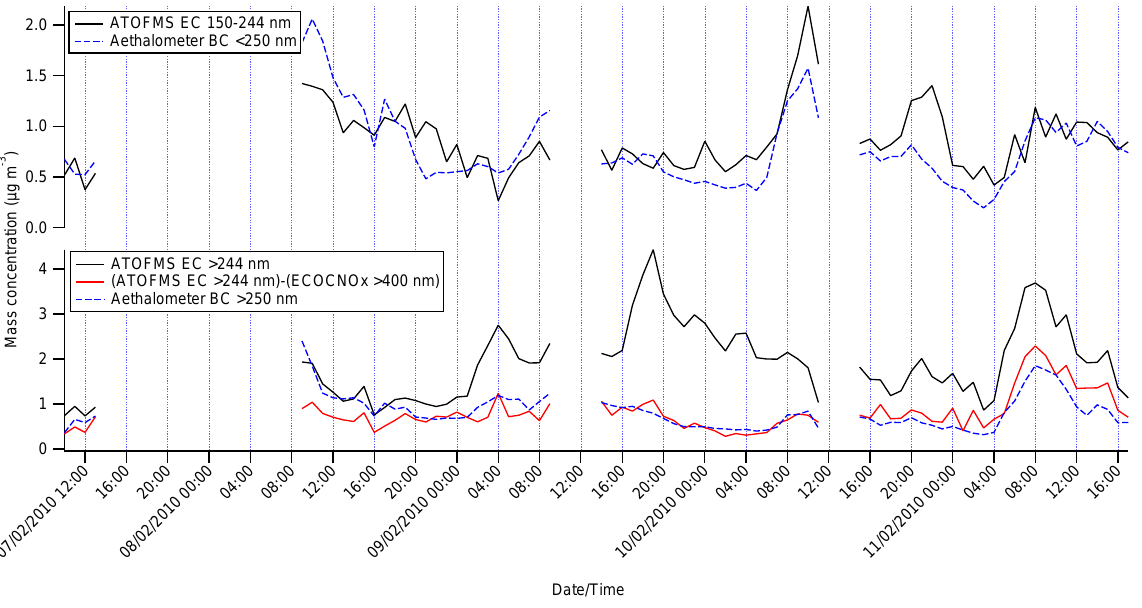
Fig. 8. Top: scaled ATOFMS EC particle mass concentration in the size range 150–244nm and mass concentration of BC < 250nm measured with the aethalometer. Bottom: scaled ATOFMS EC particle mass concentration > 244nm, scaled ATOFMS EC particle mass concentra- tion > 244nm minus ATOFMS ECOCNO x > 400nm, and aethalometer BC > 250nm mass concentration estimated by comparing the two aethalometer